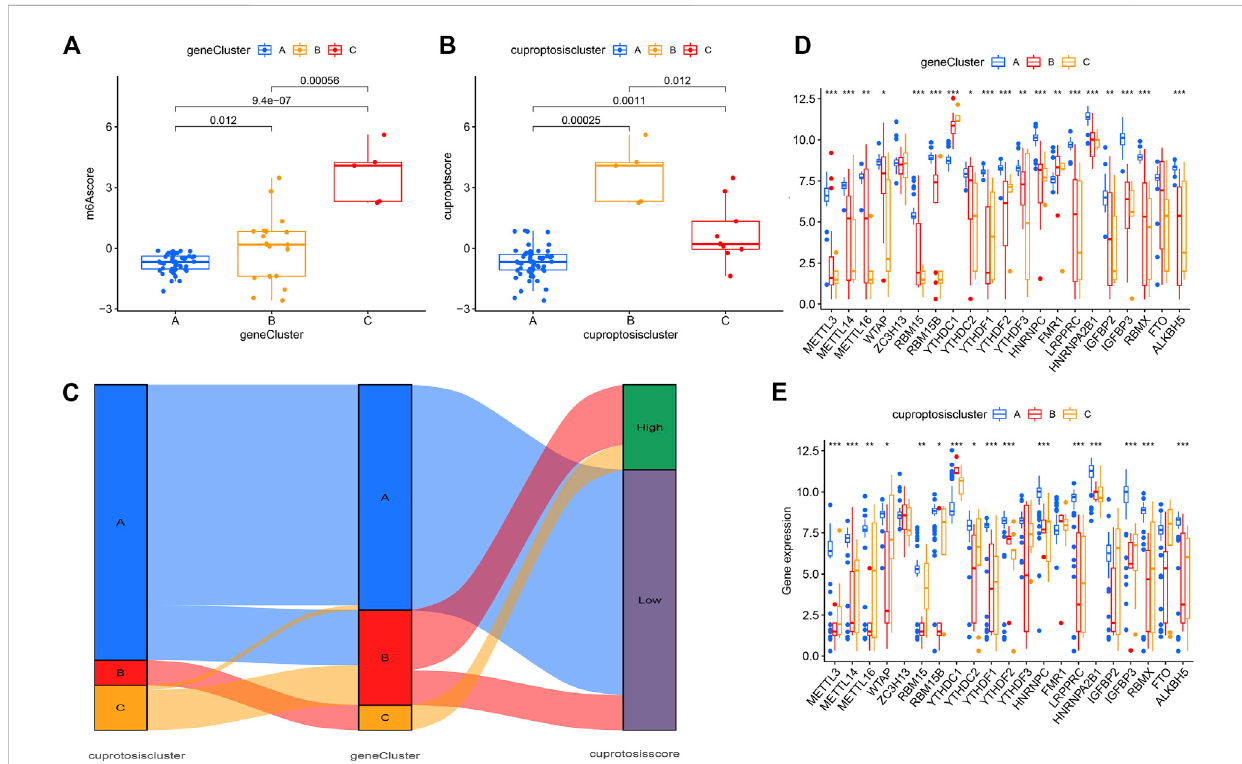
FIGURE 8 Roles of cuproptosis patterns in distinguishing psoriasis. (A) Differences in cuproptosis score between clusterA, clusterB and clusterC. (B) Differences in cuproptosis score between gene clusterA, gene clusterB and gene clusterC. (C) Sankey diagram showing the relationship between cuproptosis patterns. (D – E) Differential expression of 23 m6A regulators clusterA, clusterB and clusterC in gene pattern and cuproptosis pattern. * p < 0.05, ** p < 0.01, and *** p < 0.001.